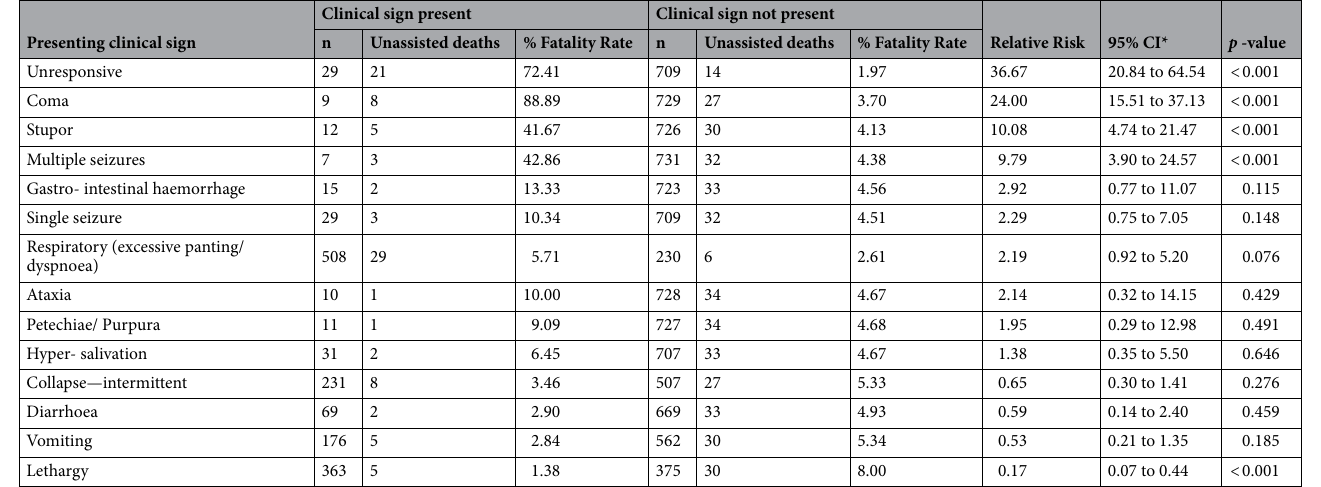
Table 3. Proportional fatality and relative risk for unassisted death (excluding euthanasia) in dogs recorded with specific clinical signs of heat-related illness cases presenting to primary-care veterinary practices in the UK between 2016 and 2018. Relative risk describes the risk ratio of death in heat-related illness cases recorded with this clinical sign compared to cases without this clinical sign. *CI confidence interval, n =